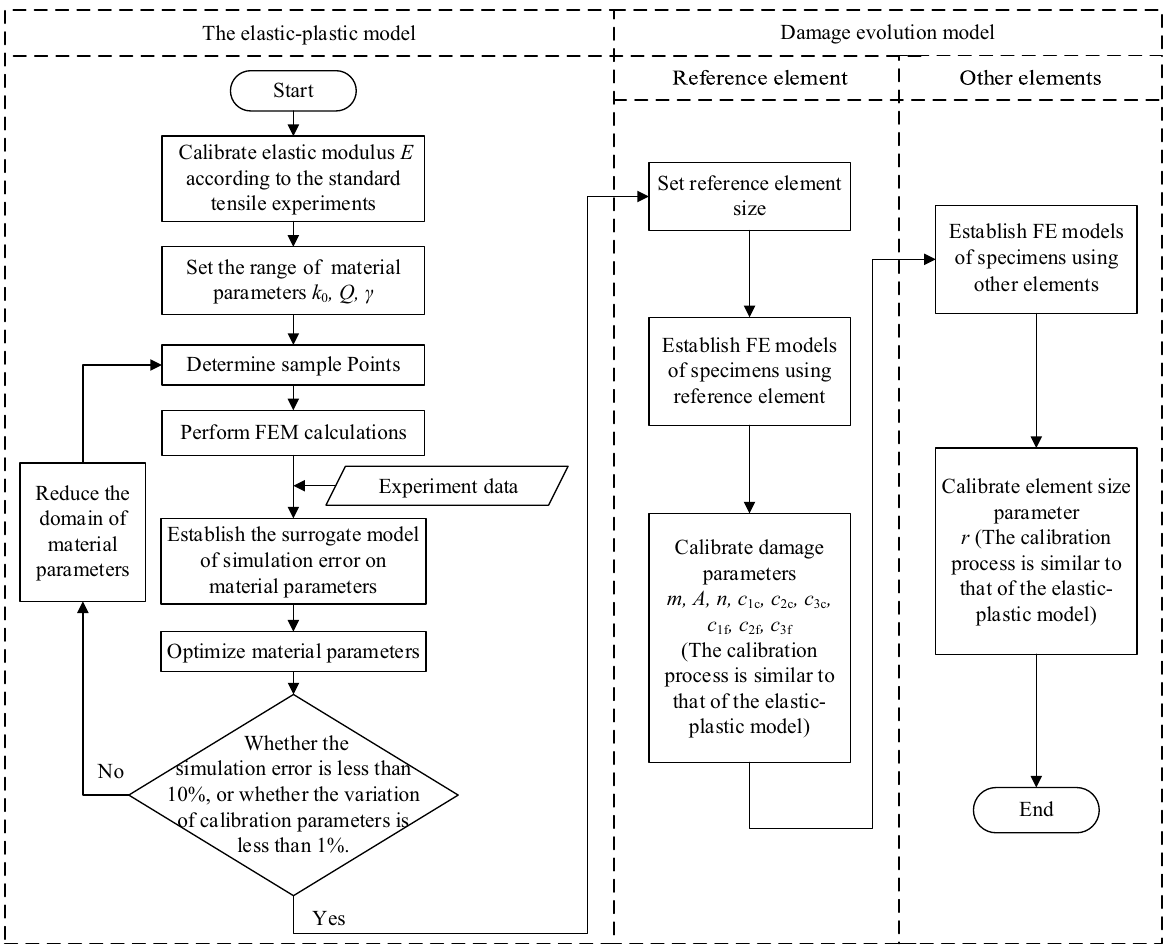
Figure 3 Parameter calibration flow chart of constitutive